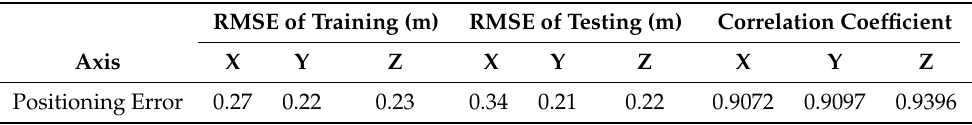
Table 4. Prediction errors and correlation coefficient of dynamic experimental